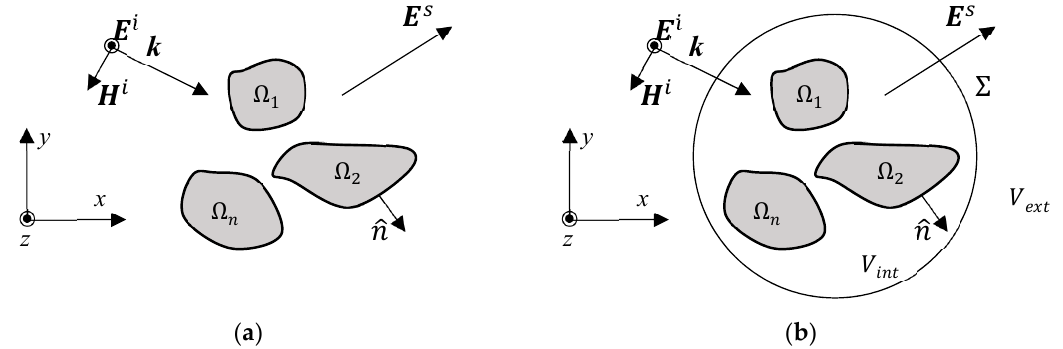
Figure 1. The analyzed scattering problem: n arbitrarily shaped objects are illuminated by a known incident field. ( a ) References for the Helmholtz problem; ( b ) references for the Dirichlet-to-Neumann (DtN) formulation.